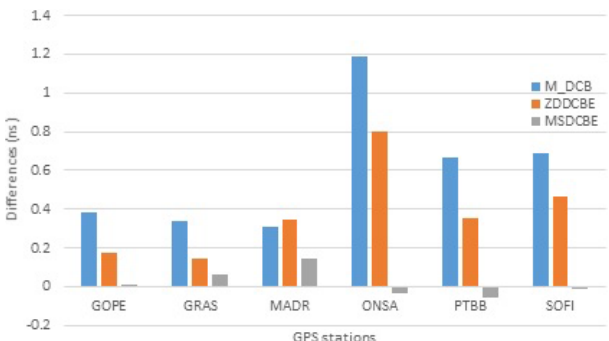
Figure 7. Mean difference between the receiver DCB values of the IGS and the computed values by each of M_DCB, ZDDCBE, and MSDCBE estimated from 1 to 5 January